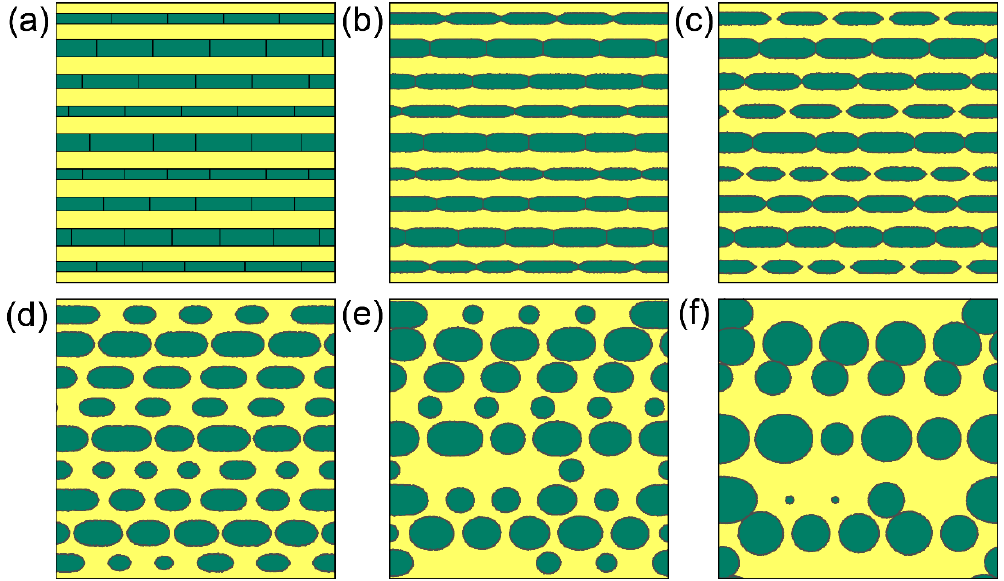
Figure 10. Microstructure evolution of a system with long cylinders with inner substructures, which shows a combination of Rayleigh instability and Ostwald ripening. ( a ) t = 0 s; ( b ) t = 0.2 s; ( c ) t = 0.4 s; ( d ) t = 1 s; ( e ) t = 2 s; ( f ) t = 4 s. Simulation grid is 1600 × 1600 with cell size of 0.001 μm.